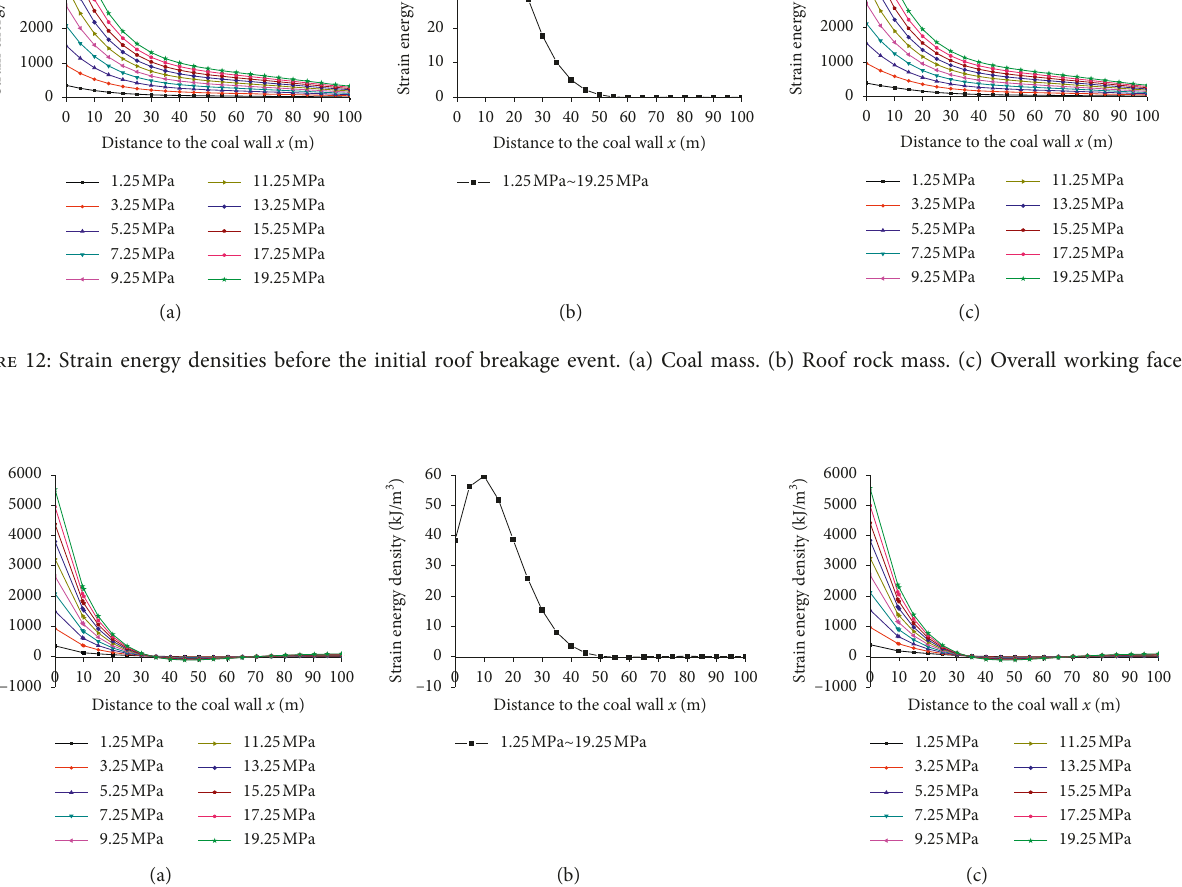
Figure 13: Strain energy density variation before and after the initial roof breakage event. (a) Coal mass. (b) Roof rock mass. (c) Overall working face.